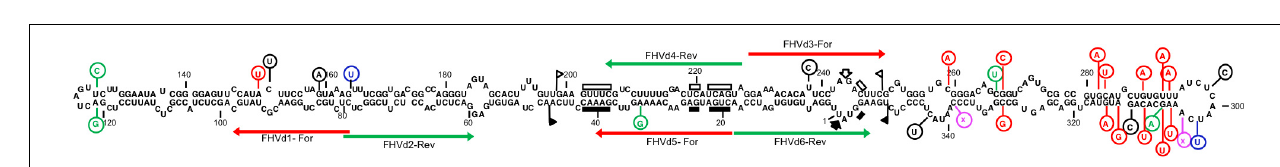
FIGURE 3 | Primary and predicted secondary structures of lowest free energy of the fig hammerhead viroid-like RNA variant A1 (FHVd-LR_A1) collected from the island of Oahu. Regions involved in the formation of ( + ) and ( − ) hammerhead structures are delimited by flags; arrows and bars indicate the self-cleavage sites and the nucleotides conserved in most natural hammerhead structures, respectively; filled (black) and open symbols refer to ( + ) and ( − ) polarity, respectively. Mutated positions in other FHVd-LR variants are indicated in circles, with compensatory mutations, insertions, and deletions reported in green, blue, and pink, respectively. Nucleotide changes with respect to the short VL-RNA from the island of Kauai are in red. Horizontal arrows delimit the regions targeted by primer pairs used in the amplification steps of the cloning and sequencing